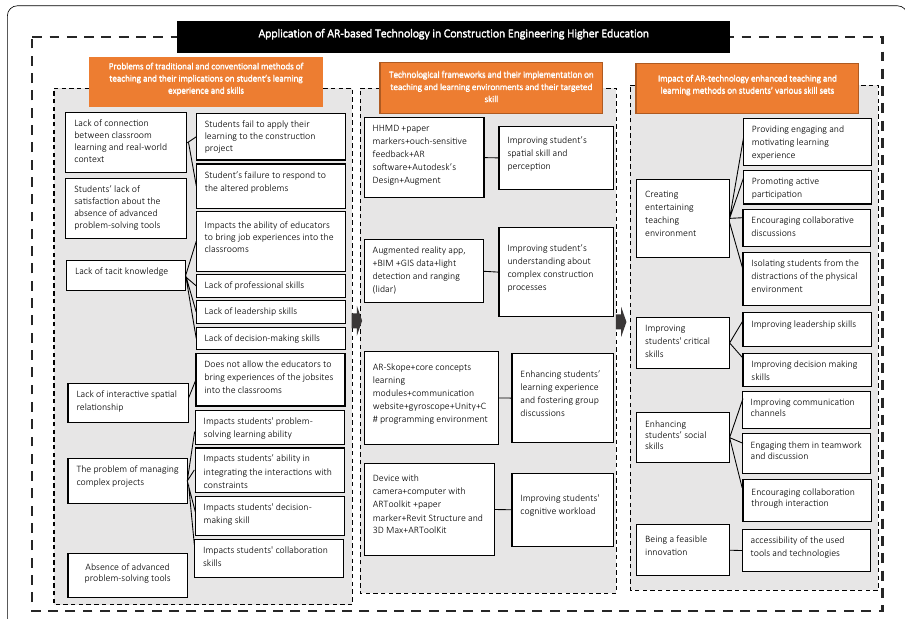
Fig. 7 The application of AR-based technology in construction higher